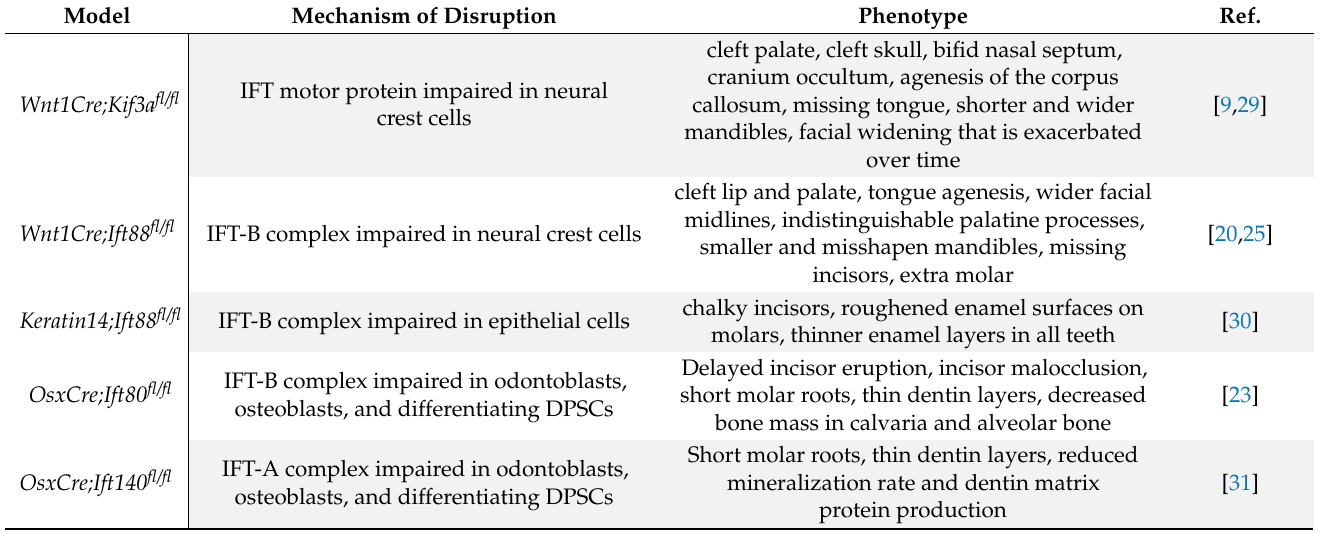
Table 1. Summary of reported craniofacial phenotypes in mouse models with disrupted primary cilia